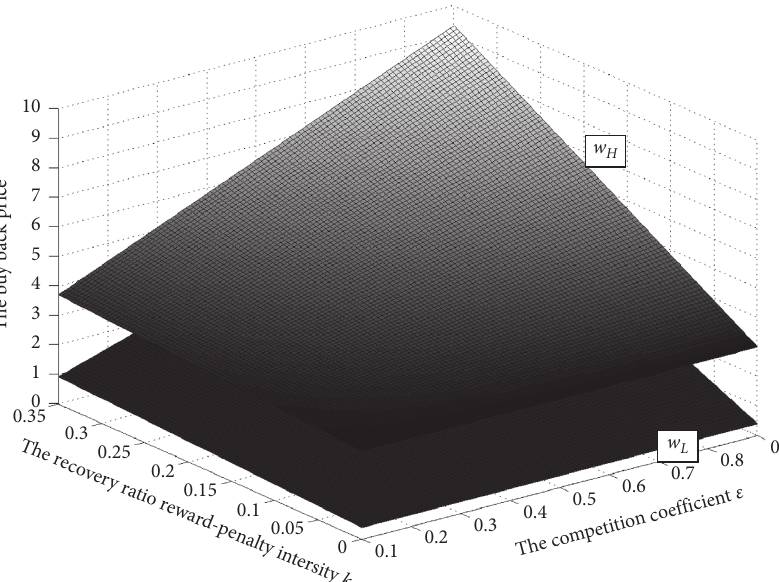
Figure 8: WEEE buyback price w